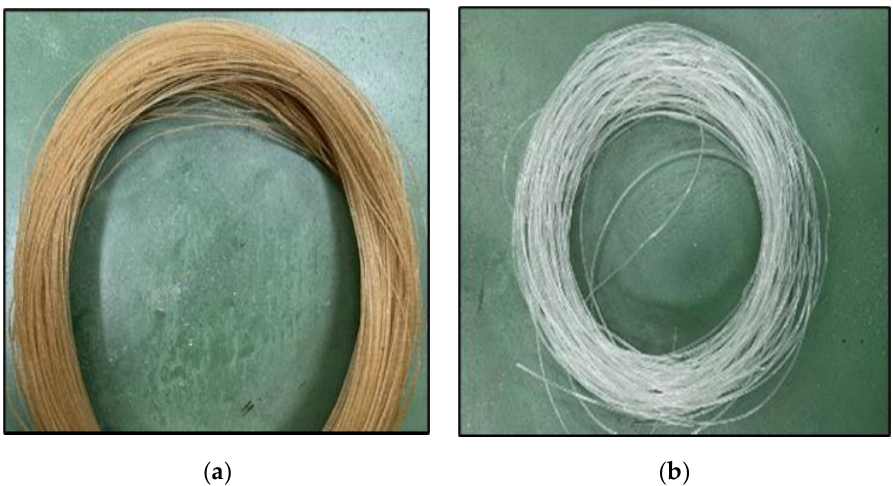
Figure 2. Kenaf fibre reinforced PLA composites: ( a ) Kenaf fibre PLA composites filament; ( b ) Neat polymer filament.